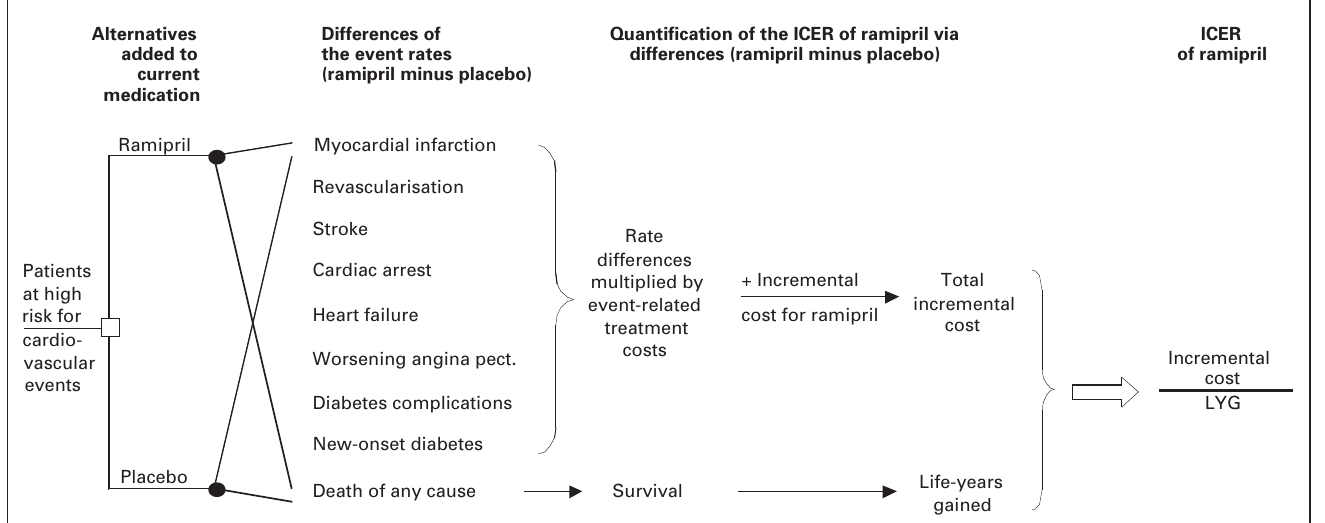
Figure 1 Decision tree of the cost-effectiveness